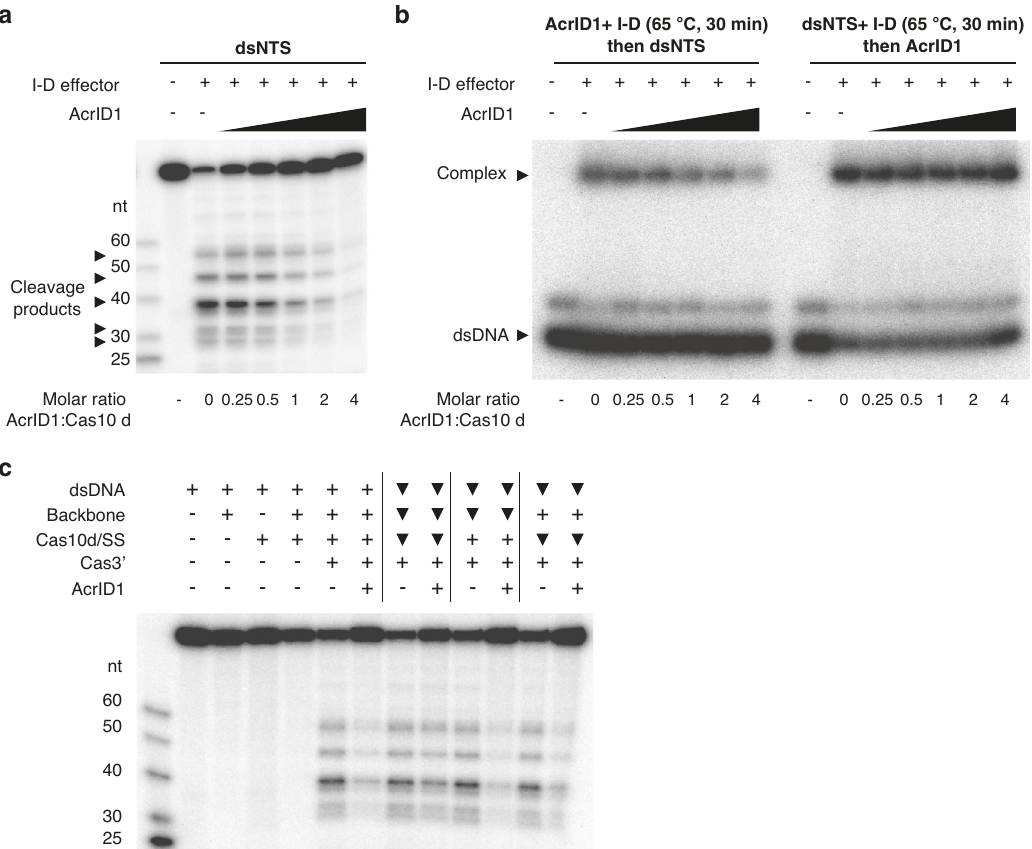
Fig. 4 AcrID1 prevents formation of a cleavage-competent I-D effector complex. a In vitro DNA cleavage assay. Each reaction contained the type I-D effector complex components (backbone, Cas10d/SS, and Cas3 ’ ) and radio-labelled double-stranded target DNA (dsNTS), either in the absence or presence of increasing amounts of AcrID1, as indicated. The molar ratio of AcrID1 to Cas10d is indicated below the gel and major cleavage products are indicated with arrowheads on the side. The fi rst lane is a molecular weight marker containing DNA fragments of known length as indicated (nt). b Electrophoretic mobility shift assay (EMSA) showing interaction between radio-labelled dsDNA (dsNTS) and the type I-D effector complex (backbone + Cas10d/SS) either in the absence or presence of increasing amounts of AcrID1, as indicated. Effector complex components (excluding Cas3 ’ ) were pre- incubated for 30 min with either AcrID1 (left) or radio-labelled dsDNA (right). The positions of naked dsDNA and the DNA-bound effector complex ( “ complex ” ) are indicated with arrowheads. c In vitro DNA cleavage assay with conditions as in ( a ). All reactions contained radio-labelled double-stranded target DNA (dsNTS) as well as the indicated type I-D effector complex components (backbone, Cas10d/SS, Cas3 ’ , and/or AcrID1). Components marked with a fi lled, black triangle were preincubated for 20 min prior to adding the other components. The fi rst lane is a molecular weight marker containing DNA fragments of known length as indicated (nt). All gels are representative of three experiments with similar results. Source data are provided as a Source data fi